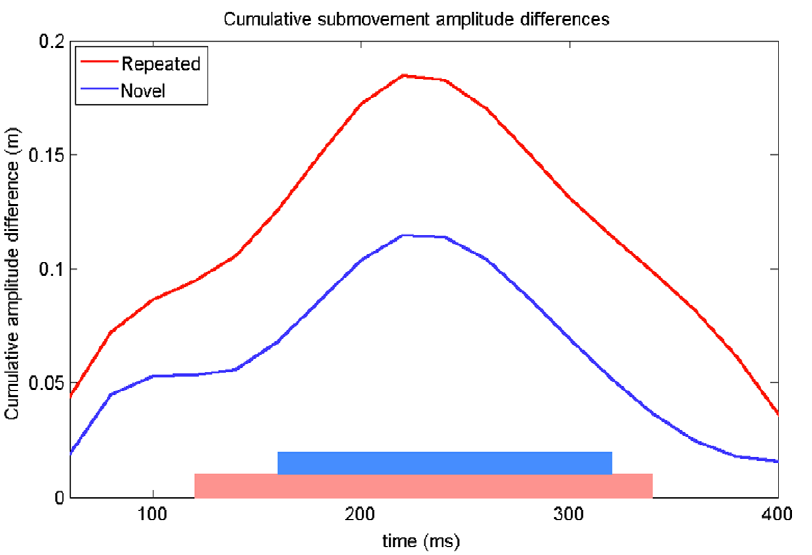
Figure 6. Submovement cumulative amplitude differences from Experiment 1. The difference (incongruent – congruent) in the mean cumulative submovement amplitude is plotted. The shaded regions along the x-axis indicate when the 95% confidence intervals calculated over the difference scores do not include zero.